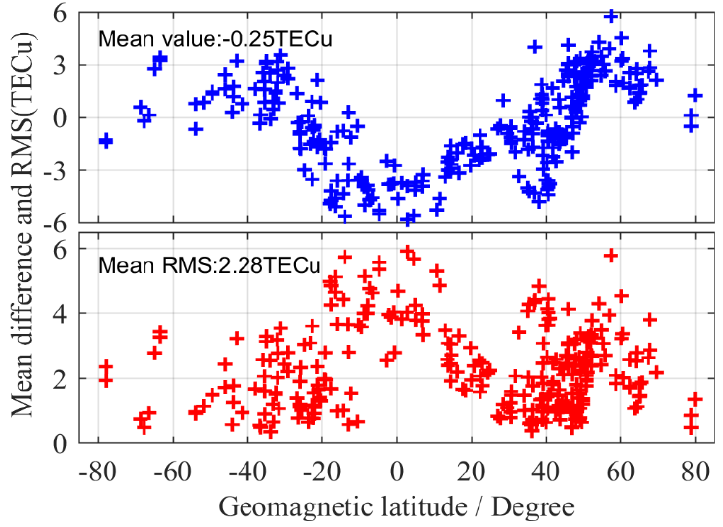
Figure 5. VTEC series value of the IGDE and CODE product for the four stations on DOY 011.